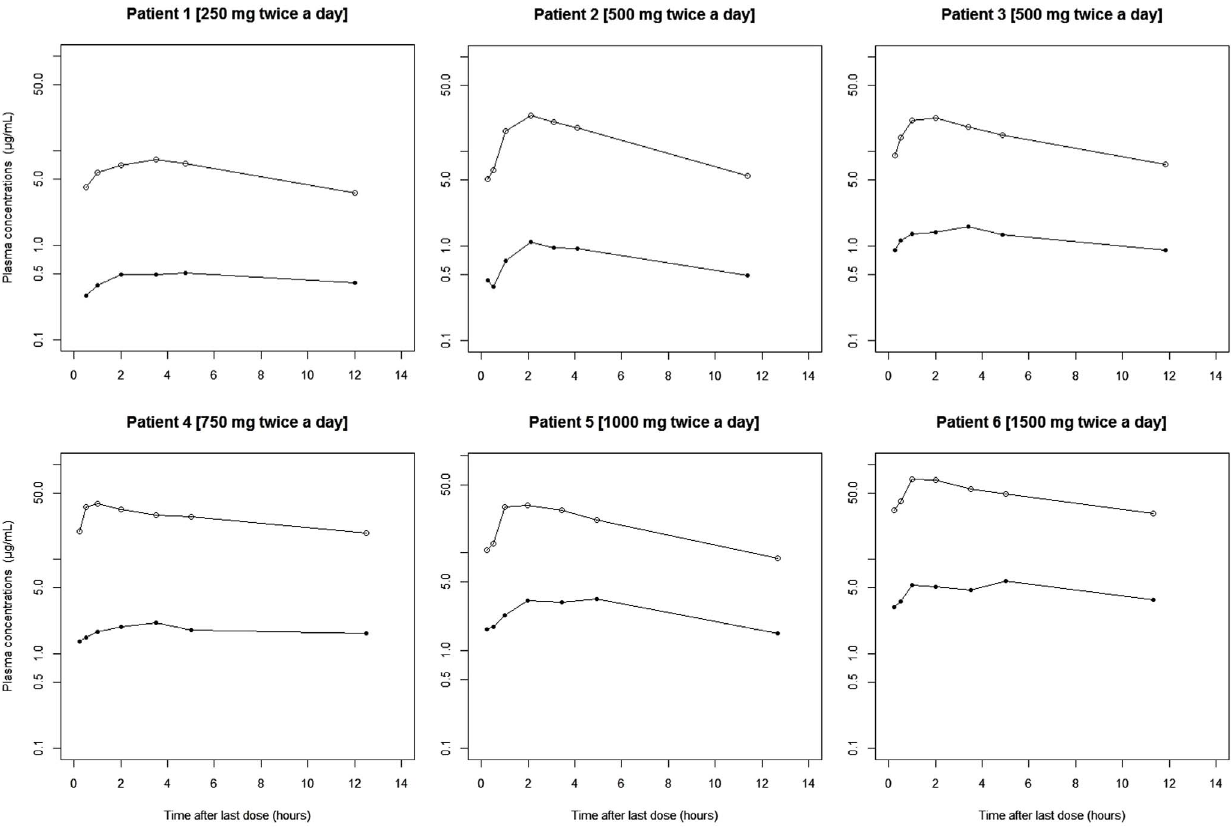
Figure 4. Representative semi-log plots of plasma concentrations of LEV ( # ) and UCB L057 ( N ) versus time after last dose of 6 patients with epilepsy on maintenance dose of oral